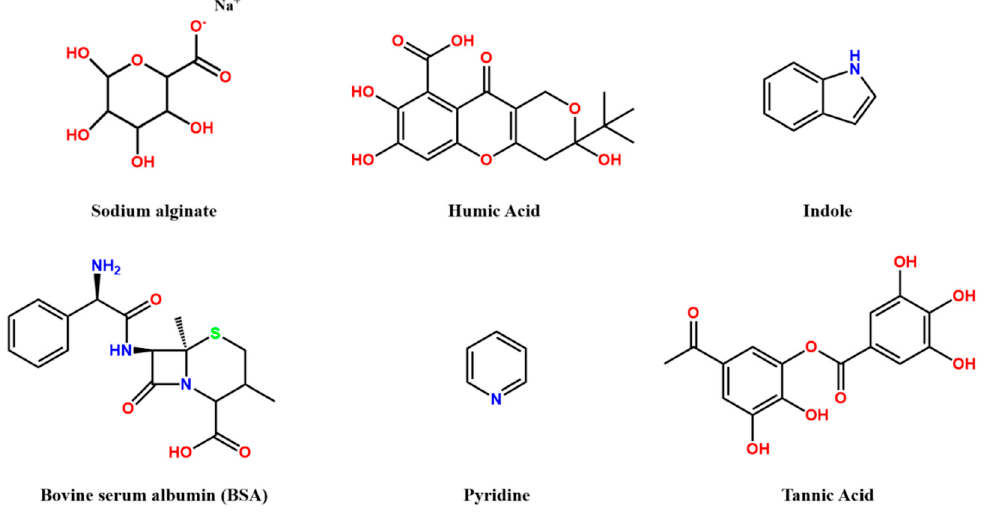
Figure 2. Simplified chemical structures for some of the organic foulants.